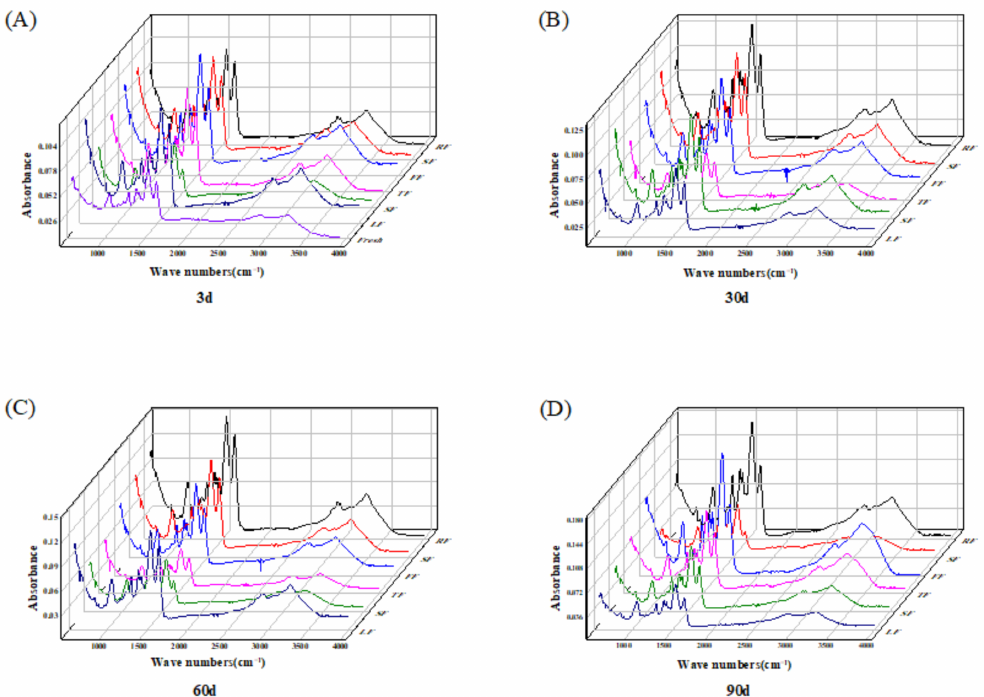
Figure 7. ATR-FTIR spectra of cuttlefish with different freezing methods during freezing at − 18 ◦ C. ( A – D , represent the samples stored for 3 d, 30 d, 60 d, 90 d,